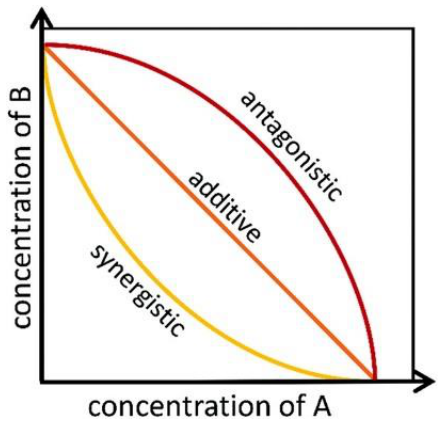
Figure 3. Schematic diagram of the isobologram curve to determine allelopathic interactions.